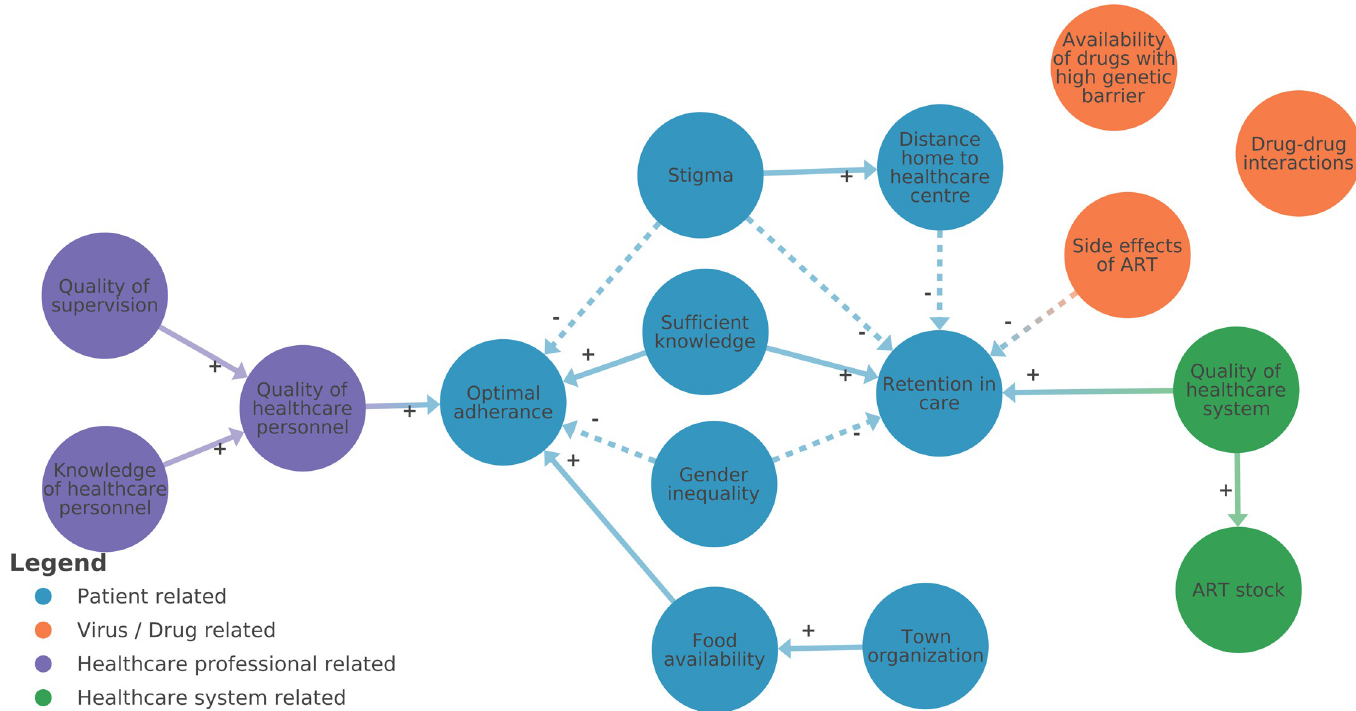
Fig 3. Mental model example. Example of a mental model of an interviewee, visualizing the elements and connections which came up during the interview and which are perceived to be true by the interviewee. The researcher tried to bring some first structure in the model by using a color code.